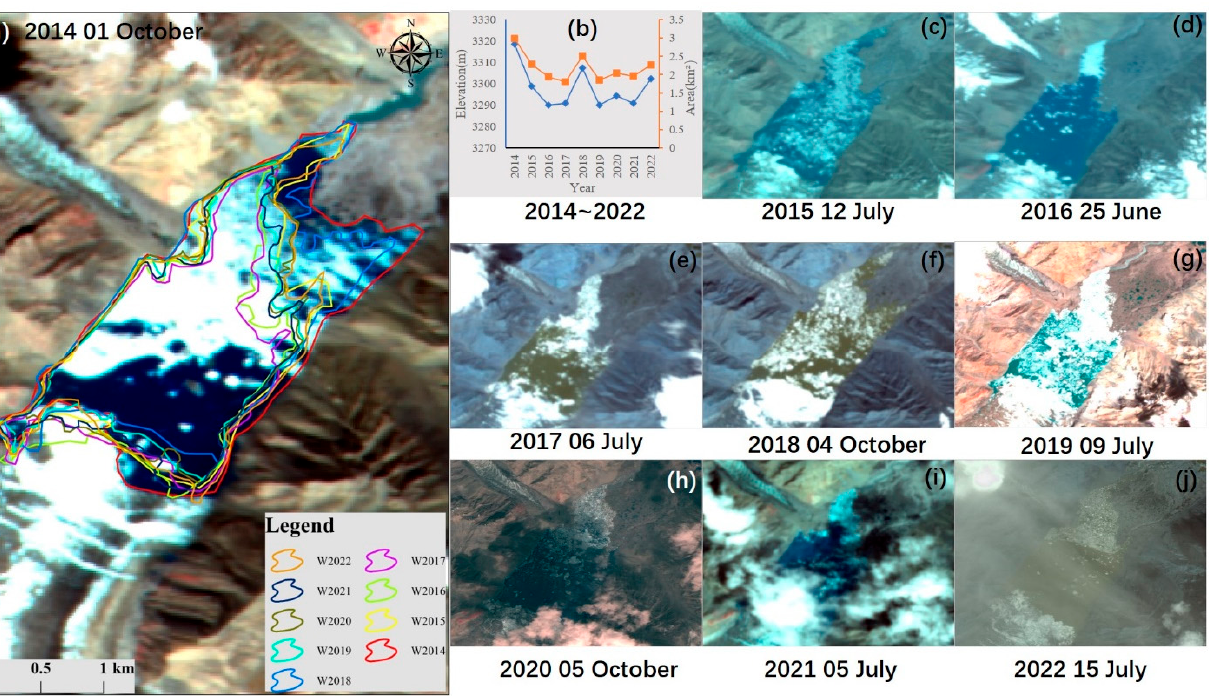
Figure 3. Maximum lake area (MLA) change before outburst since 2014. ( a ) MLA extent in each year and overlay on the image obtained on 1 August 2014; ( b ) MLA changes from 2014 to 2022; ( c – j ) MLA overlay on images obtained from 2015 to 2022.